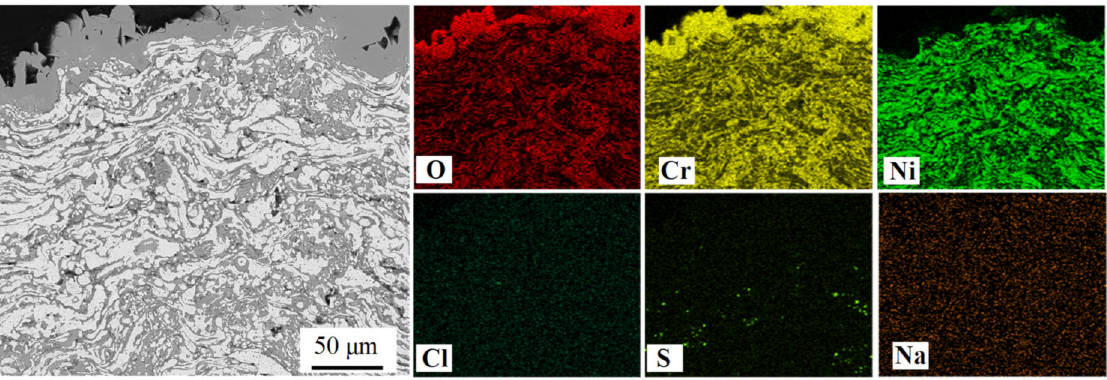
Figure 8. The elemental mappings of a cross-section of NiCrTi-Air coating after the hot corrosion test.